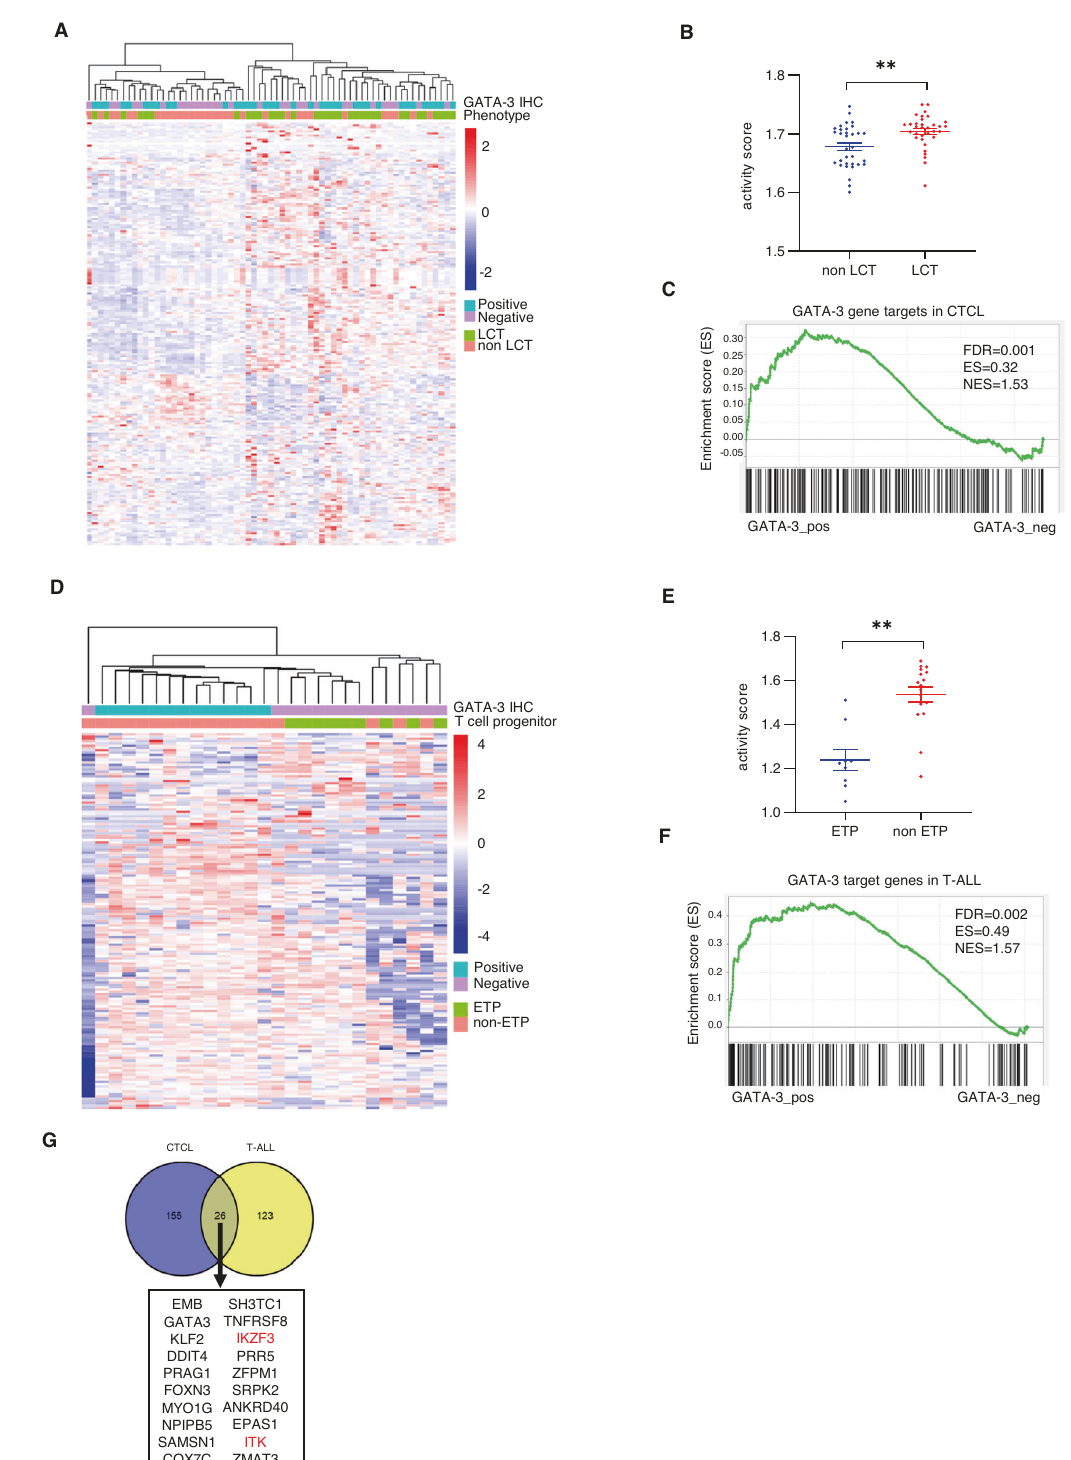
receptor signaling in B cells, has transformed the therapeutic landscape in many B-cell lymphomas [43 – 45]. Pre-clinical studies suggest that ITK inhibition may be a viable therapeutic strategy in MTCL [3], and a clinical trial investigating a fi rst-in-class, selective and irreversible ITK inhibitor is ongoing in these